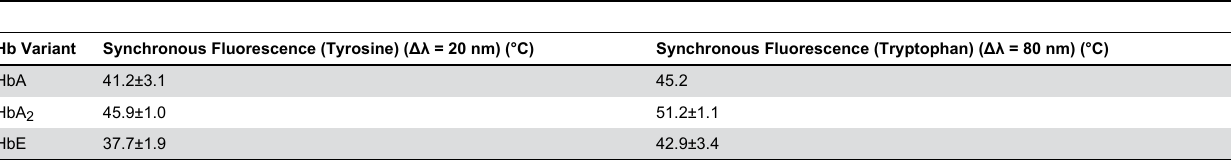
and HbE at pH 7. 2